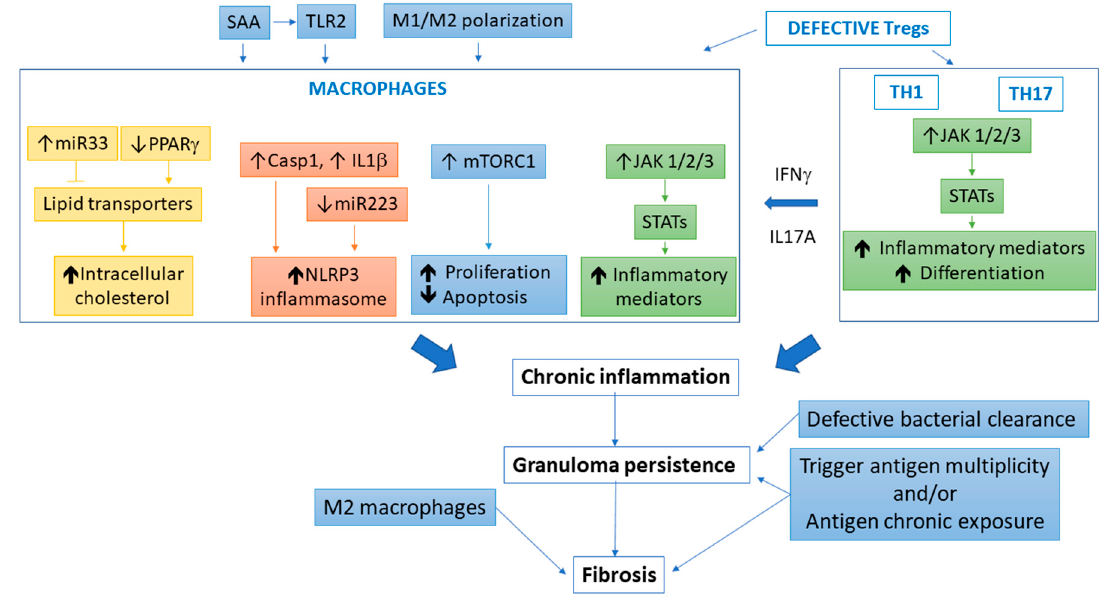
Figure 1. Models contribution to the understanding of sarcoidosis disease progression. In sarcoidosis, an uncontrolled pro-inflammatory phenotype takes place and appears to be amplified by the activation of both extracellular (SAA, macrophage polarization, Treg deficiency) and intracellular (TLR2, lipid metabolism, NLRP3 inflammasome, mTORC1, JAK / STAT) signaling pathways. Activation of these intracellular pathways promotes a chronic inflammatory status of macrophages. The switch “chronic inflammation / granuloma persistence” is probably due to either trigger antigens multiplicity or / and antigen chronic exposure associated with a defect in pathogen clearance. Later, the switch to the M2-like phenotype may participate to initiate or amplify the process of fibrogenesis surrounding granulomas. mTORC1, mammalian / mechanistic target of rapamycin complex 1; PPAR, peroxisome proliferator-activated receptor; SAA, serum amyloid A; TLR, toll-like receptor; Casp1, caspase 1; NLRP3, NOD-like receptor (NLR) pyrin domain-containing protein 3; JAK, Janus kinase; SAA, serum amyloid A; STAT, signal transducers and activators of transcription.